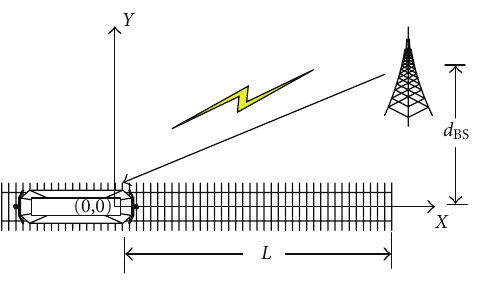
Figure 1: The simulation scenario.